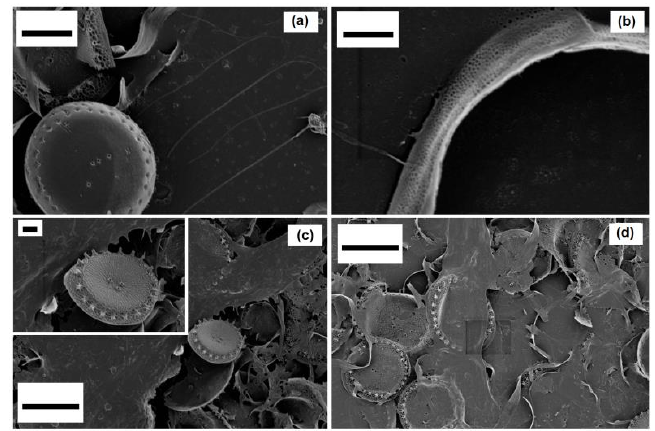
Figure 13. SEM pictures of NHDF ( a – c ) and Saos-2 ( d ) cells grown for 24 h on frustules containing surfaces. ( a ) Cell filopodia directing toward a frustule; ( b ) cell filopodium interacting with a girdle; ( c ) cell’s lamellipodia interacting with a frustule (inset at higher magnification); ( d ) cells covering structured surface. Marker: ( a ) 5 µm; ( b ) 1 µm; 10 µm for ( c ) and ( d ) (2 µm for inset).